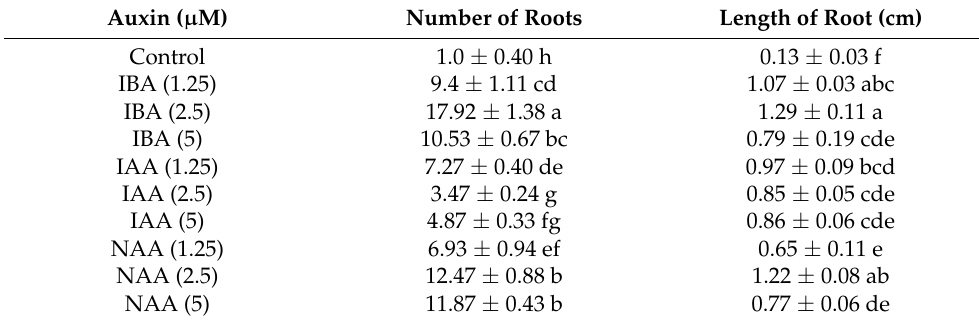
Table 4. Effect of different auxins and their concentrations towards the number of roots and length of root (cm) of P. niruri . Auxin ( µ